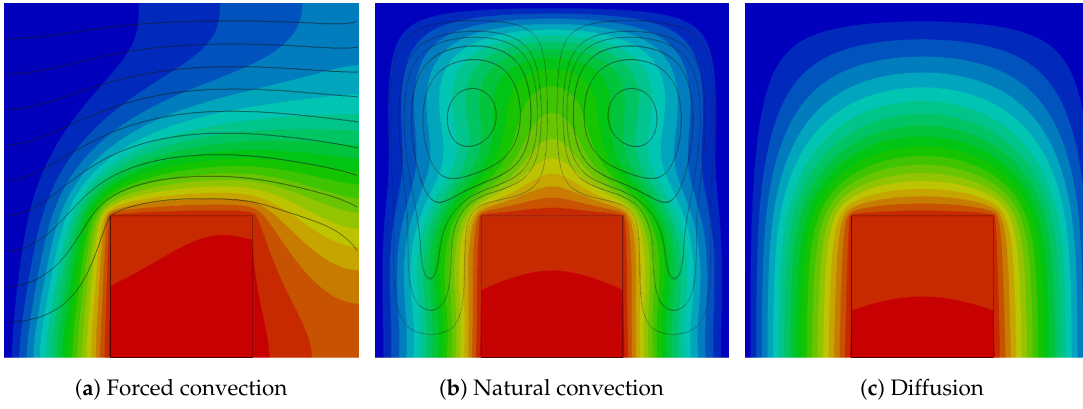
Figure 2. Illustration of a metallic block subjected to different heat transfer mechanism in the surrounding fluid. ( a ) shows forced convection with a cold flow entering at the left-hand side; ( b , c ) show natural convection and pure diffusion, respectively, due to cold upper and side walls. Reproduced with permission from Alexandersen et al.